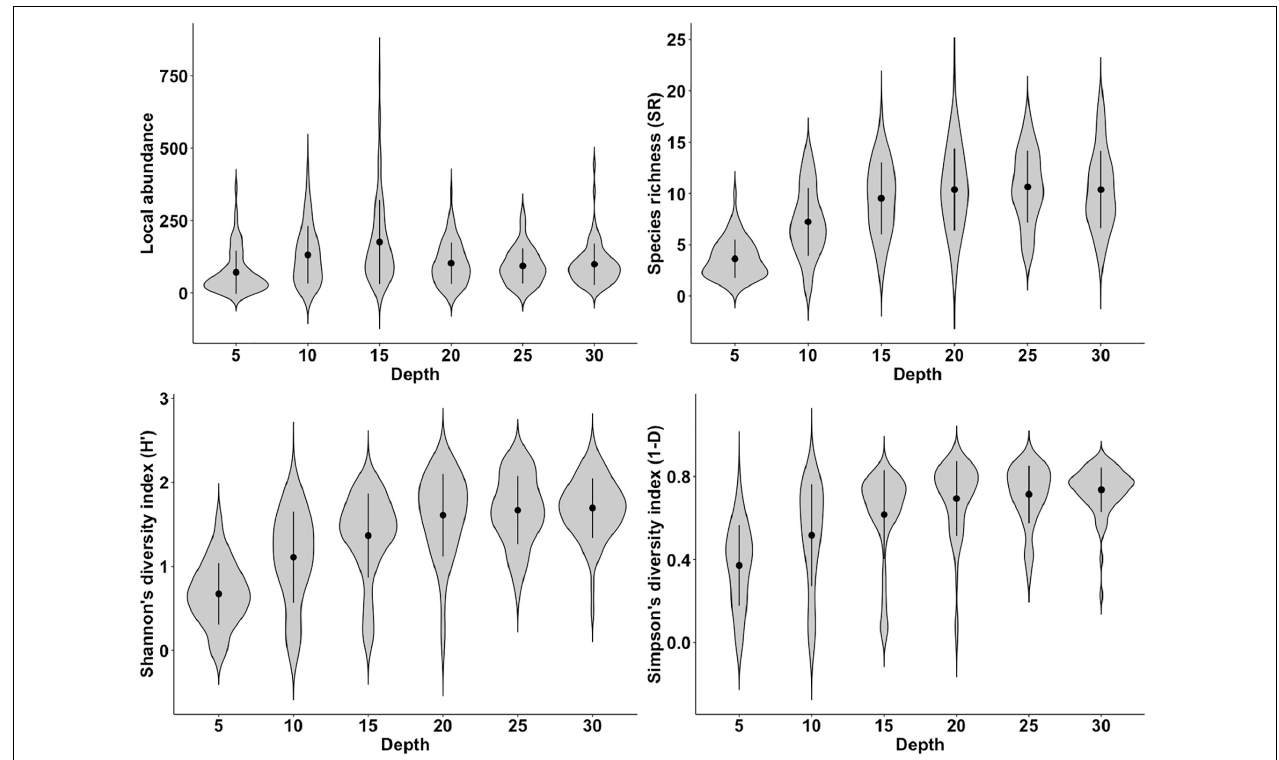
FIGURE 3 | Variation of four community metrics [local abundance of organisms, species richness (SR), Shannon’s diversity index (H (cid:48) ), and Simpson’s diversity index (1-D)] in relation to depth of sampling, expressed in meters. Blacks dots and vertical lines represent, respectively the mean and the Standard Deviation for each violin-plot.